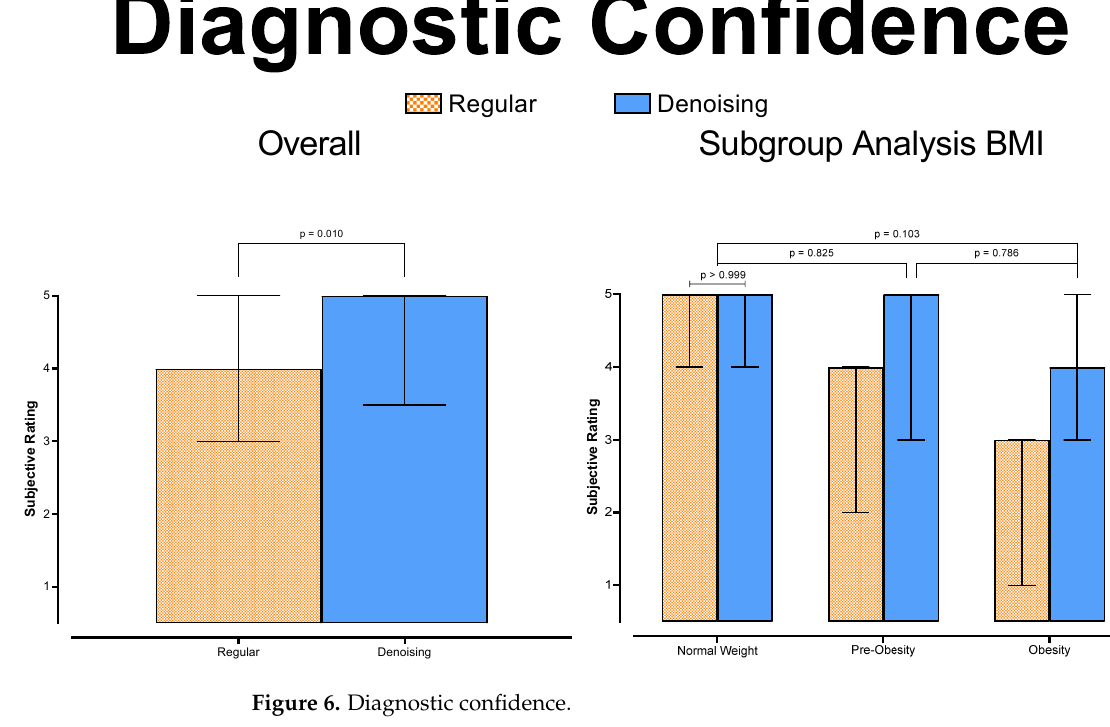
Figure 6. Diagnostic confidence.